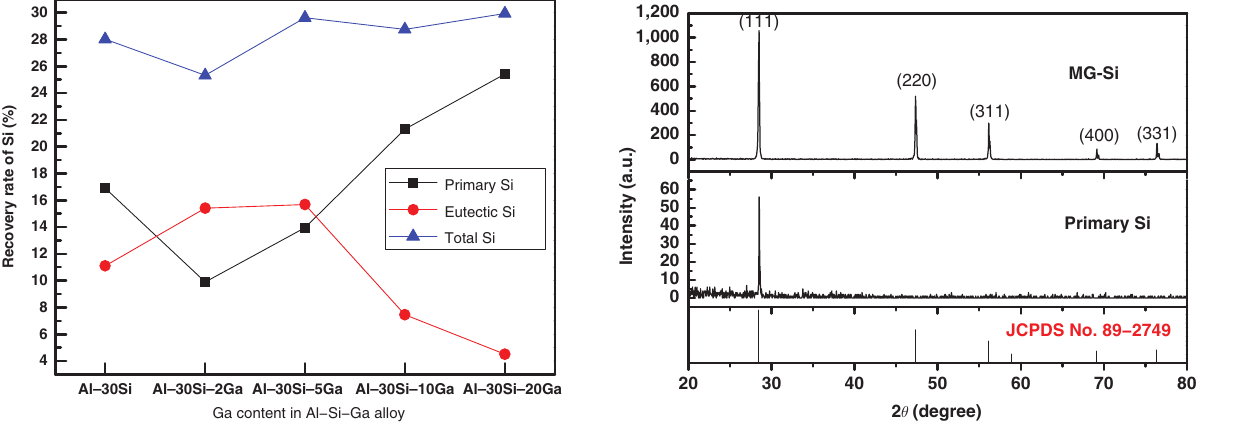
Figure 9: XRD patterns of MG-Si and primary Si after Al – 30% Si – 5% Ga alloy solvent